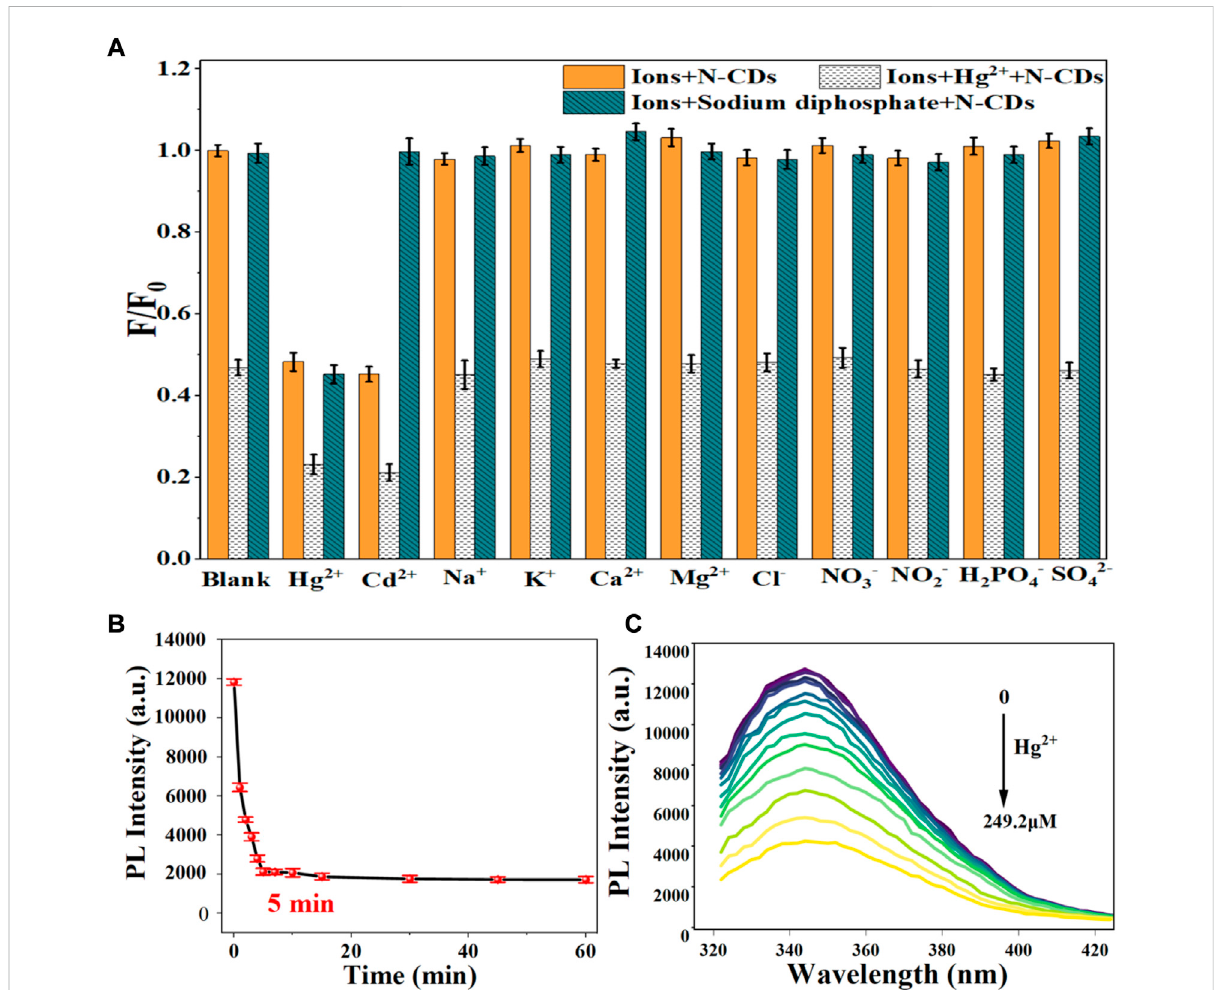
FIGURE 6 (A) SelectivityofN-CDsdetectiontoHg 2+ ; (B) IncubationtimeofN-CDswithHg 2+ ; (C) FluorescenceemissionspectraofN-CDsunderdifferent concentrations of Hg 2+